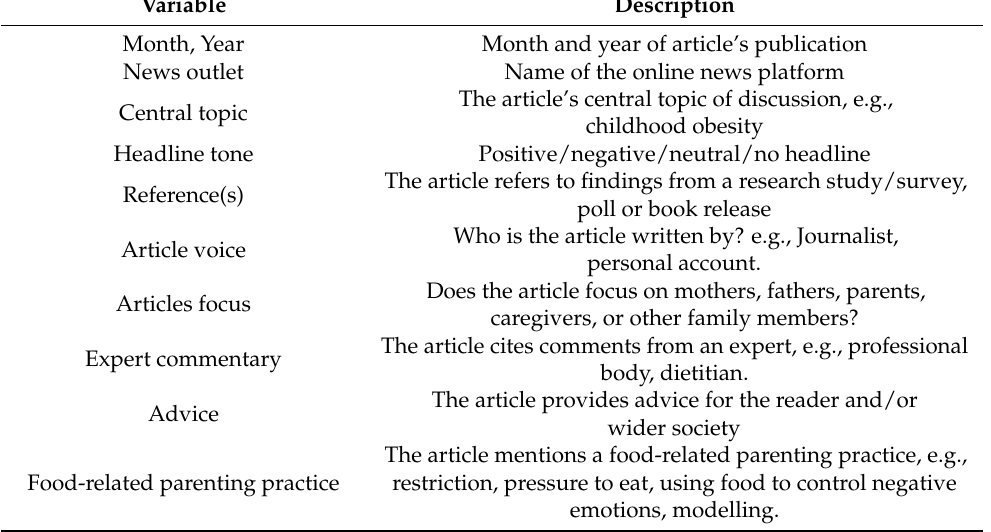
Table 1. Coding framework for news